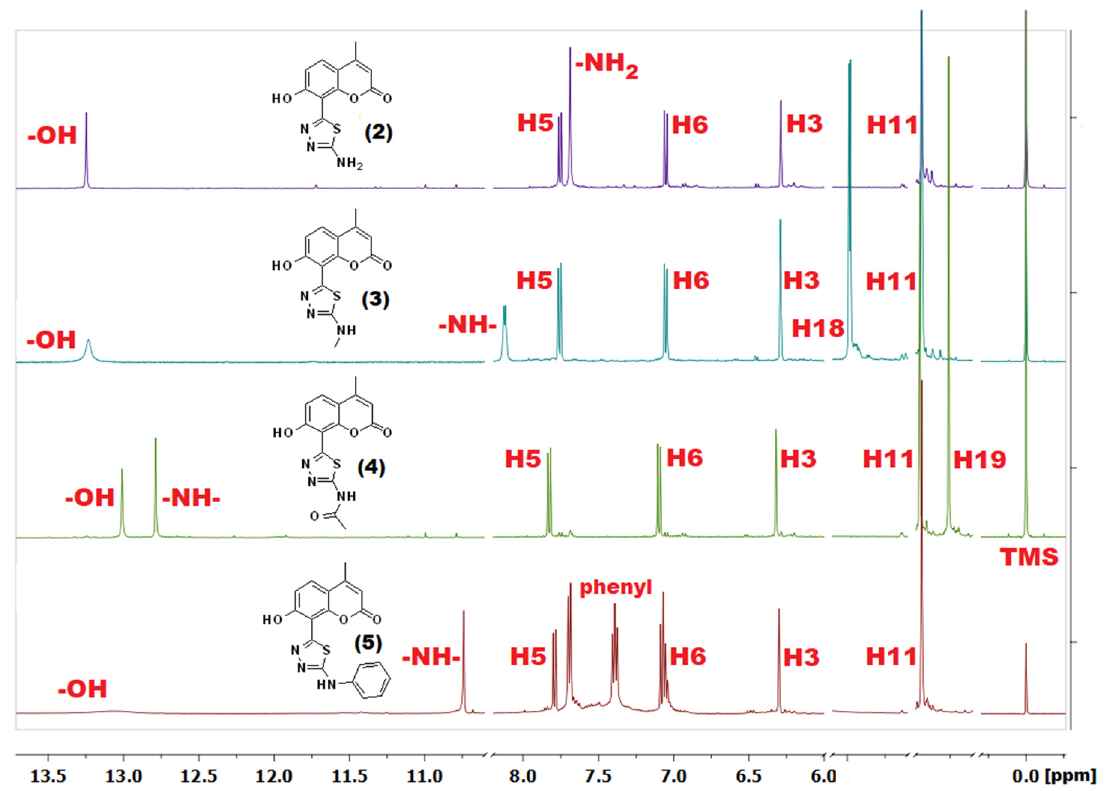
Figure 6. 1 H-NMR spectra of coumarin-thiadiazole hybrids ( 2 – 5 ) in DMSO-d 6 (water and residual DMSO signals [42] are removed for better clarity).